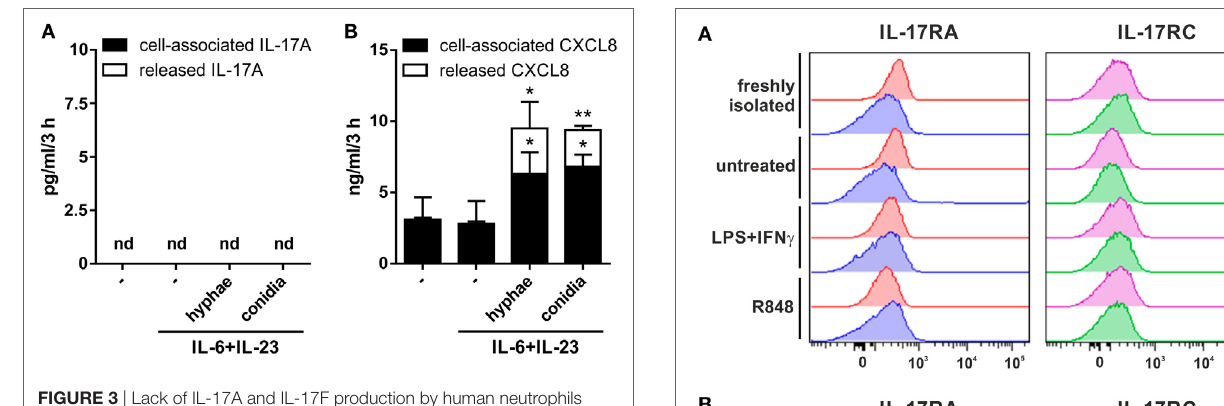
FigUre 3 | Lack of IL-17A and IL-17F production by human neutrophils activated by IL-6 plus IL-23 in combination with inactivated Aspergillus fumigatus hyphae or conidia. Neutrophils (5 × 10 6 /ml) were incubated with or without 20 µg/ml IL-6 plus 2 µg/ml IL-23 and then cultured for three more hours in the presence or not of inactivated A. fumigatus conidia and hyphae (used at 1:5 and 1:1, respectively). After incubation, IL-17A (a) and CXCL8 (B) levels were determined in cell-free supernatants and in corresponding cell pellets by specific ELISA. Values are depicted as the mean ± SD or as not detected (nd) when values were under the detection limit ( n = 3). Asterisks stand for significant differences as compared to untreated cells: * P < 0.05, ** P < 0.01, by Student’s t